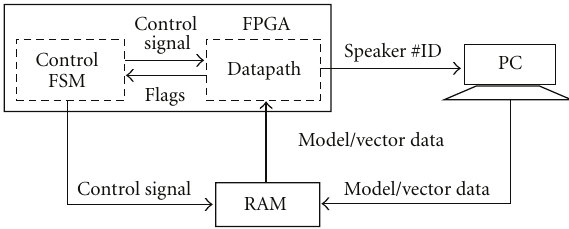
Figure 5: Top level of speaker identification